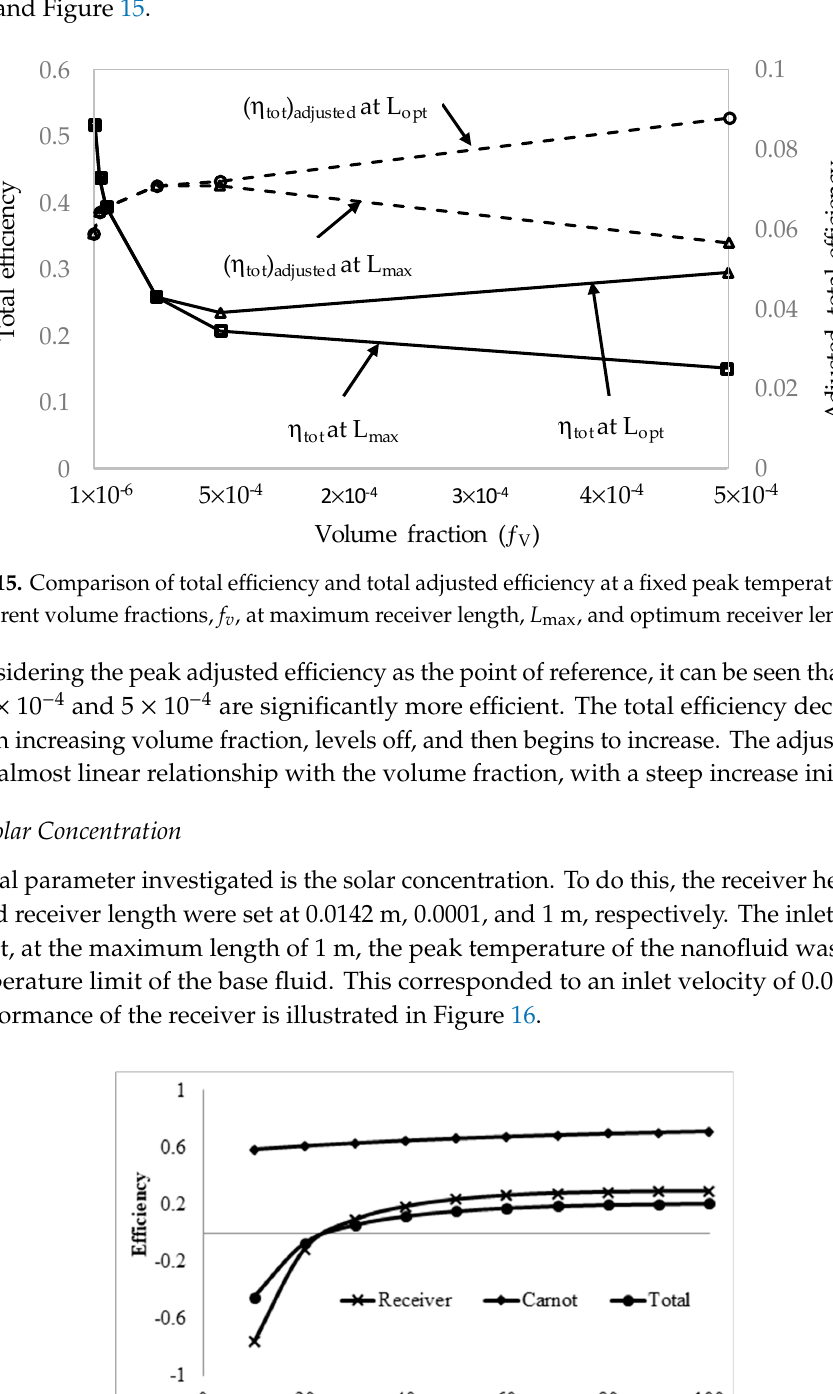
Figure 16. Effect of solar concentrations on receiver, Carnot, and total efficiencies.